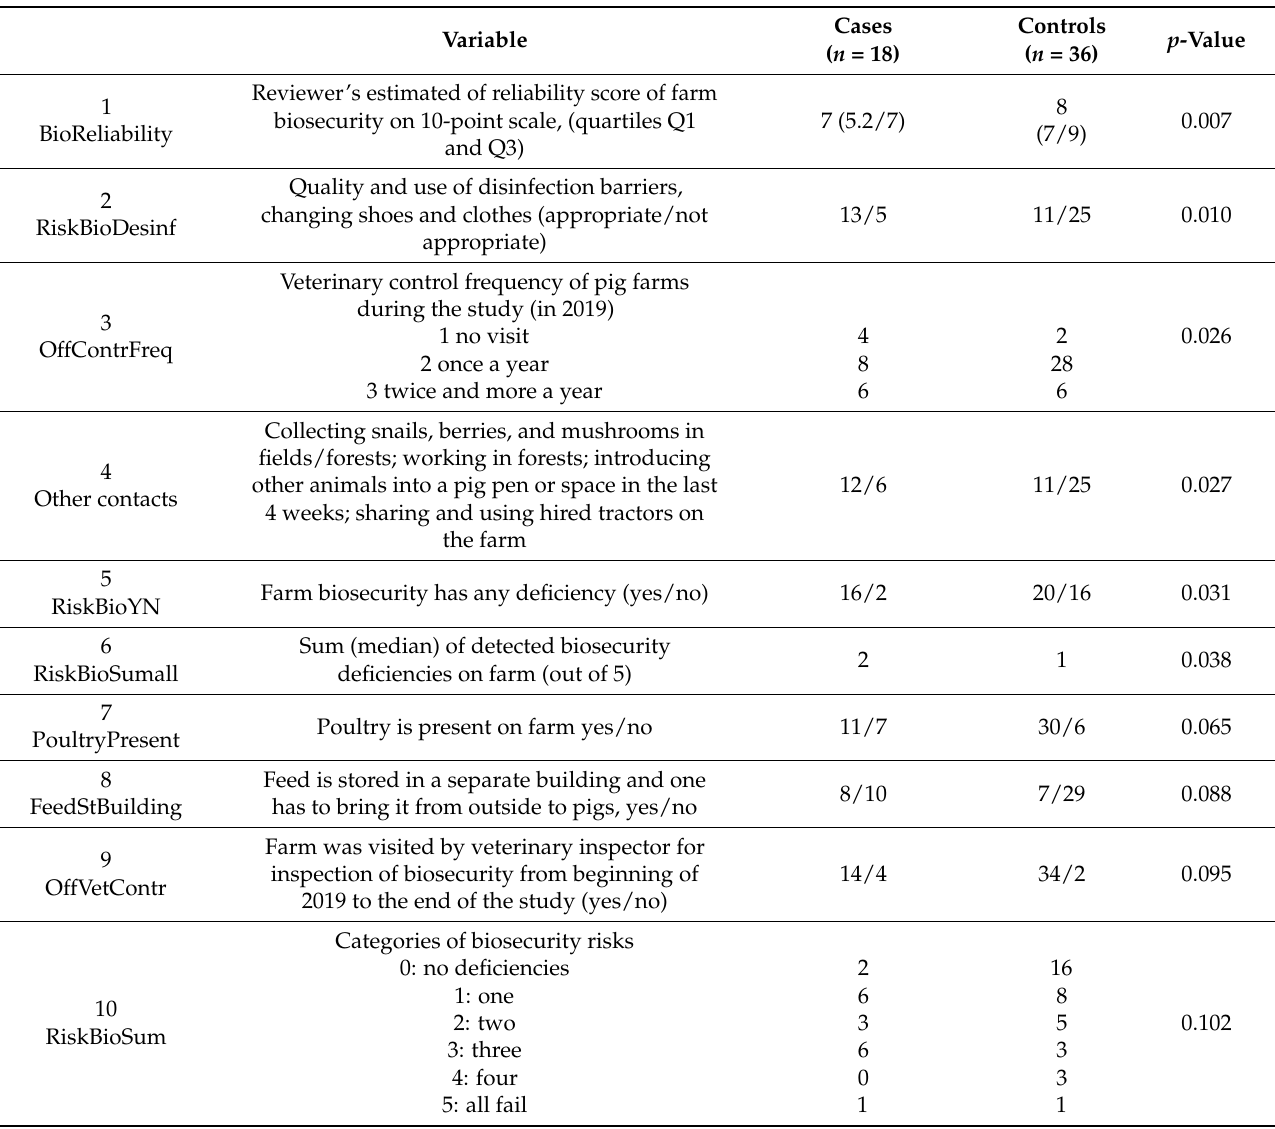
Table 1. Farm-level variables with p -values less than 0.2 in the univariable analysis of African swine fever in a case-control study of domestic pigs in Lithuania in 2019. Variable